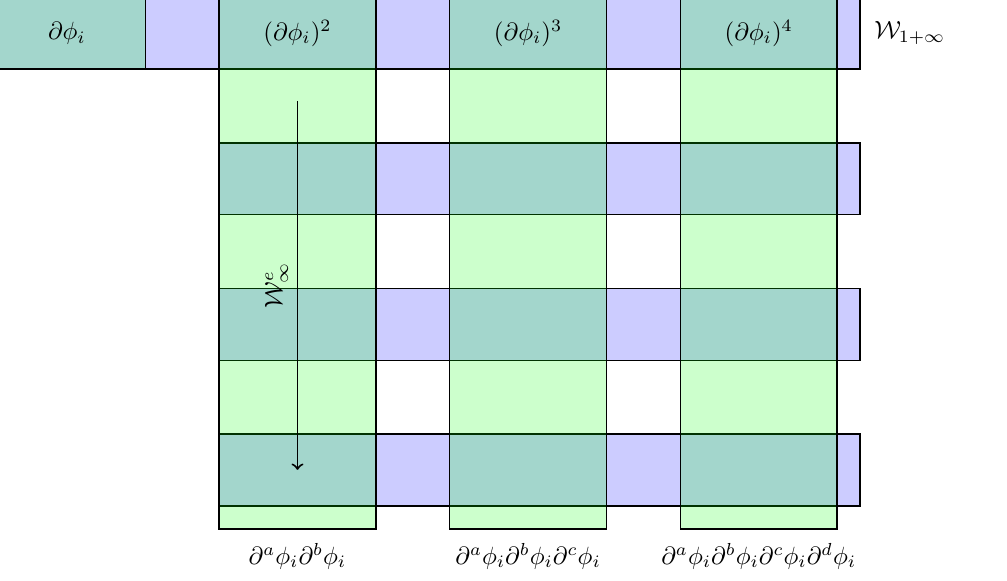
Figure 1 . The operators in the top-most row realize the [0] algebra. The full algebra is W 1+ 1 generated by acting by derivatives on the operators in the top row. The second column corresponds e to the [1] algebra while subsequent columns correspond to its representations. Operators in W 1 each row also fall into representations of W 1+ 1